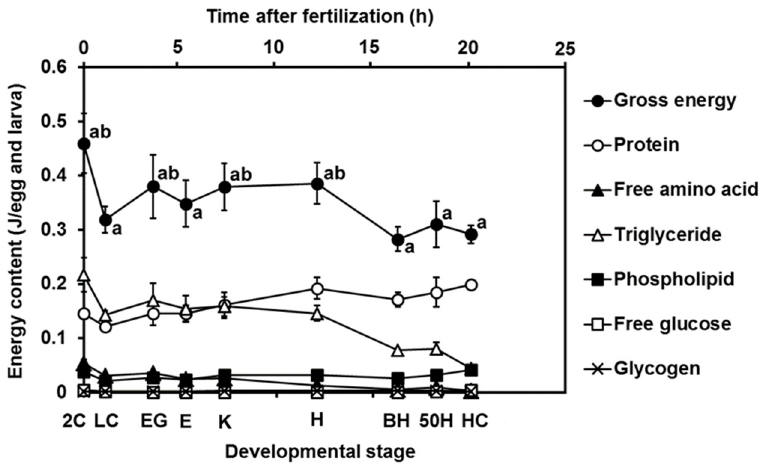
Figure 4. Changes in gross energy contents and energy composition (protein, free amino acid, triglyceride, phospholipid, free glucose, and glycogen) with the development of yellowfin tuna eggs and larvae. Values were calculated using the International Biological Program conversion factors and are presented as means ± SD. Letters next to values denote significant differences ( p < 0.05). Abbreviations are the same as those in Figure 2.